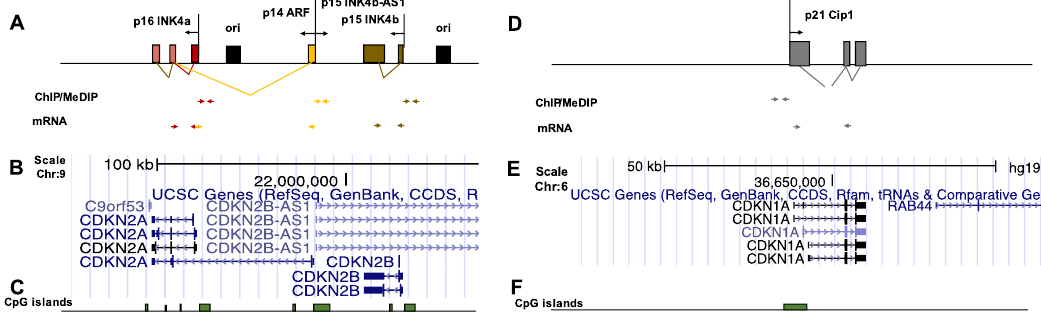
Figure 1. ( A , D ) Genomic structure of the locus of CDKN2A/B on chromosome 9 and CDKN1A ( p21CIP1 ) on chromosome 6. The arrows show the location of the primers used for RNA, chromatin immunoprecipitation (ChIP), and MEDIP analysis. ( B , E ) show the map and the structure of RNA transcripts in both loci derived from UCSC Genome Browser. ( C , F ) show the CpG islands in both loci derived from UCSC Genome Browser.